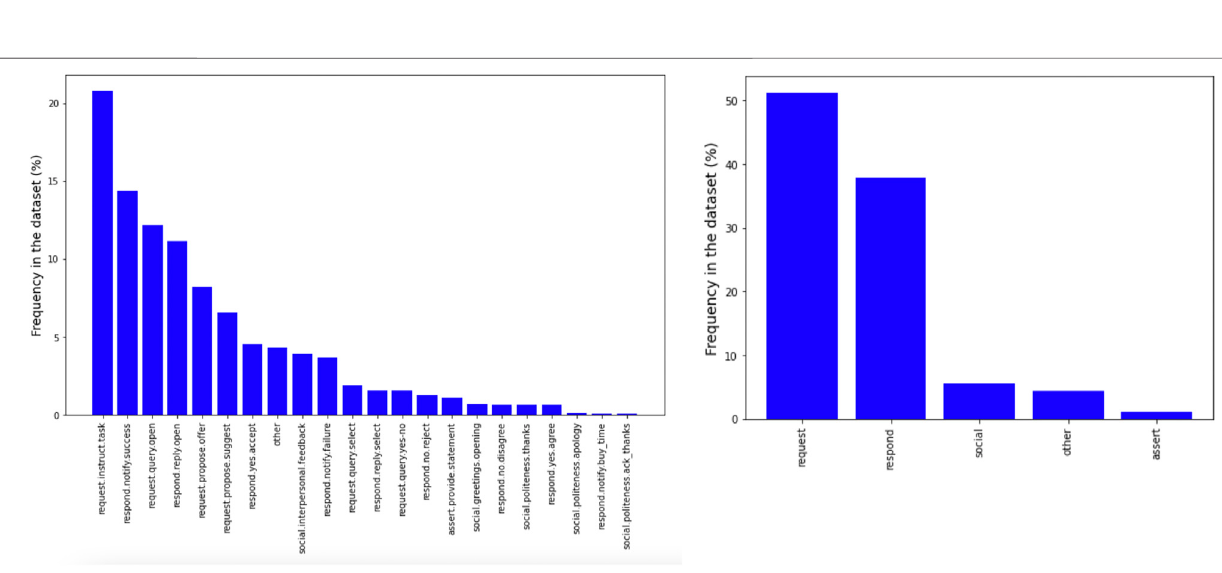
FIGURE 10 | Distribution of dialogue acts and high-level dialogue acts in